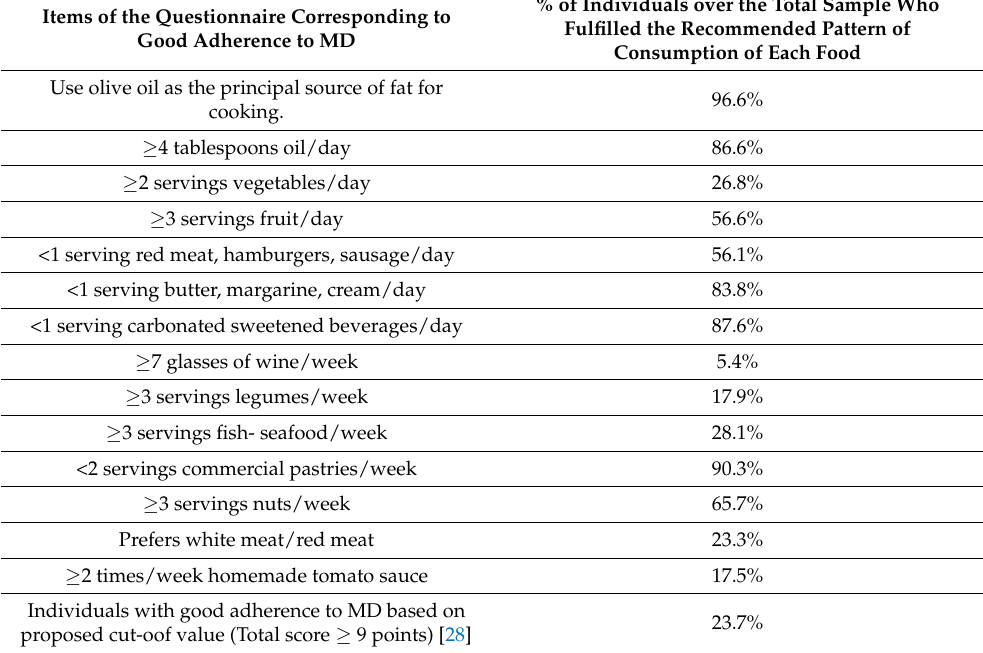
Table 2. Percentage of individuals that fulfilled the recommended frequency of consumption (on a weekly basis) of foods included in the “MD adherence